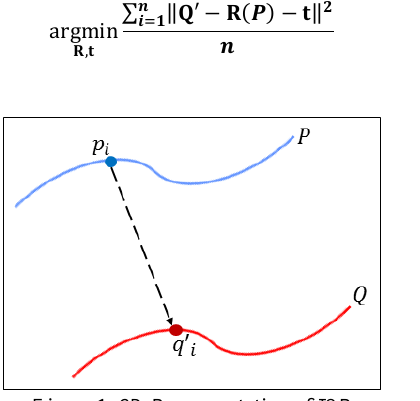
Figure 1. 2D Representation of ICP In Eq.(2), represents the correspondences for points in as shown in Figure 1. The ICP algorithm is iterative. Besl